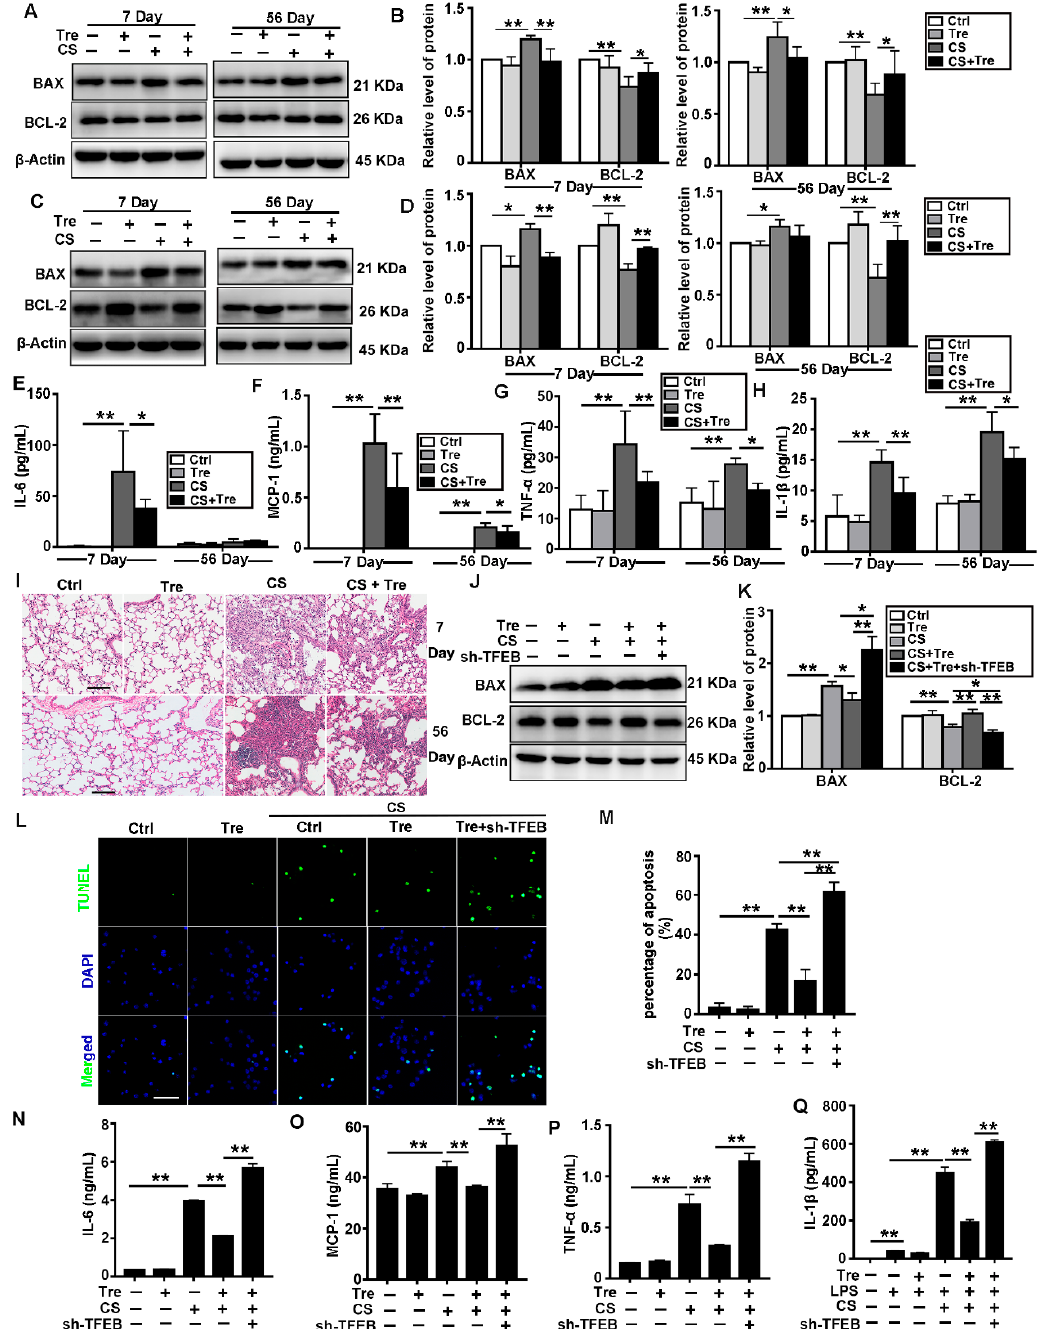
Figure 7 . Tre may relieve CS ‐ induced apoptosis and inflammation may through TFEB activation . ( A , B ) Immunoblotting analysis of BAX and BCL ‐ 2 protein levels in lungs on day 7 or 56 post CS instillation ( n = 5). ( C , D ) Immunoblotting analysis of BAX and BCL ‐ 2 protein levels in AMs on day 7 or 56 post CS instillation ( n = 3). ( E–H ) ELISA analysis of IL ‐ 6, MCP ‐ 1, TNF ‐α , and IL ‐ 1 β levels in BALF on day 7 or 56 post CS instillation ( n = 5 to 6). ( I ) H&E staining of mouse lungs on day 7 or 56 post ‐ CS instillation (scale bar = 100 μ m and n = 5). ( J , K ) Immunoblotting analysis of BAX and BCL ‐ 2 protein levels in MH ‐ S cell lines ( n = 3). ( L , M ) TUNEL (green) and DAPI (blue) staining and ratios of TUNEL ‐ positive apoptotic MH ‐ S cells (scale bar = 50 μ m and n = 3). ( N – Q ) ELISA analysis of IL ‐ 6, MCP ‐ 1, TNF ‐α , and IL ‐ 1 β levels in MH ‐ S cell supernatant ( n = 3). Data are presented as the mean ± SD. *, p < 0.05 and **, p < 0.01.